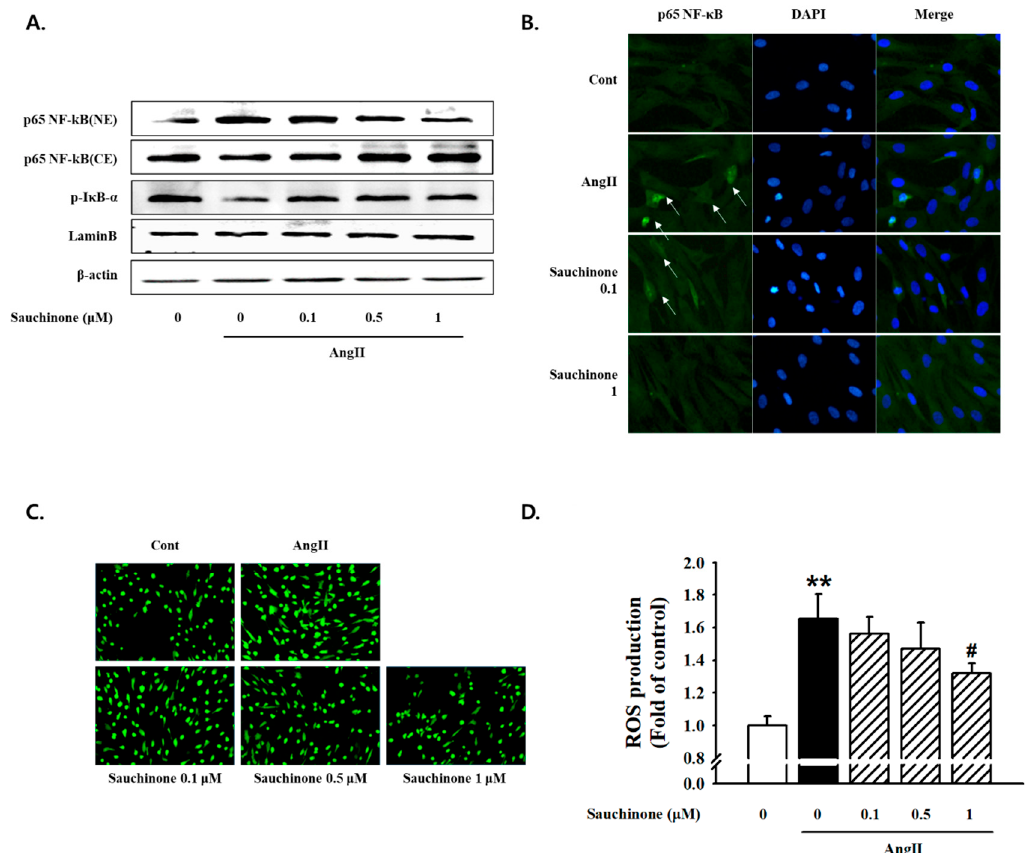
Figure 6. E ff ect of sauchinone on nuclear factor- κ B (NF- κ B) / ROS pathway. ( A ) Blockade of nuclear translocation of NF- κ B in mesangial cells. For Western blot analysis with a primary antibody against NF- κ B / p-I κ B- α , cytoplasmic (CE) and nuclear (NE) fractions were obtained. Respective blot data were obtained from three independent experiments. ( B ) Immunofluorescent staining showed the subcellular distribution of p65 in nuclei and cytoplasm. Blue and green stains indicate nuclei and p65, respectively. Independent experiments were performed at least three times with similar results (magnification. 400 × ). ( C ) Intracellular ROS levels were determined by image analysis of DCFDA-loaded cells on a fluorescence microscope (magnification. 200X). ( D ) The fluorescence intensity (Ex: 485 nm per Em: 530 nm) of each cell lysate was then measured. Intracellular ROS levels are expressed as fold change in fluorescence intensity. Each value represents the means ± S.E. of four independent experiments. ** p < 0.01 vs. control and # p < 0.05 vs. AngII alone.